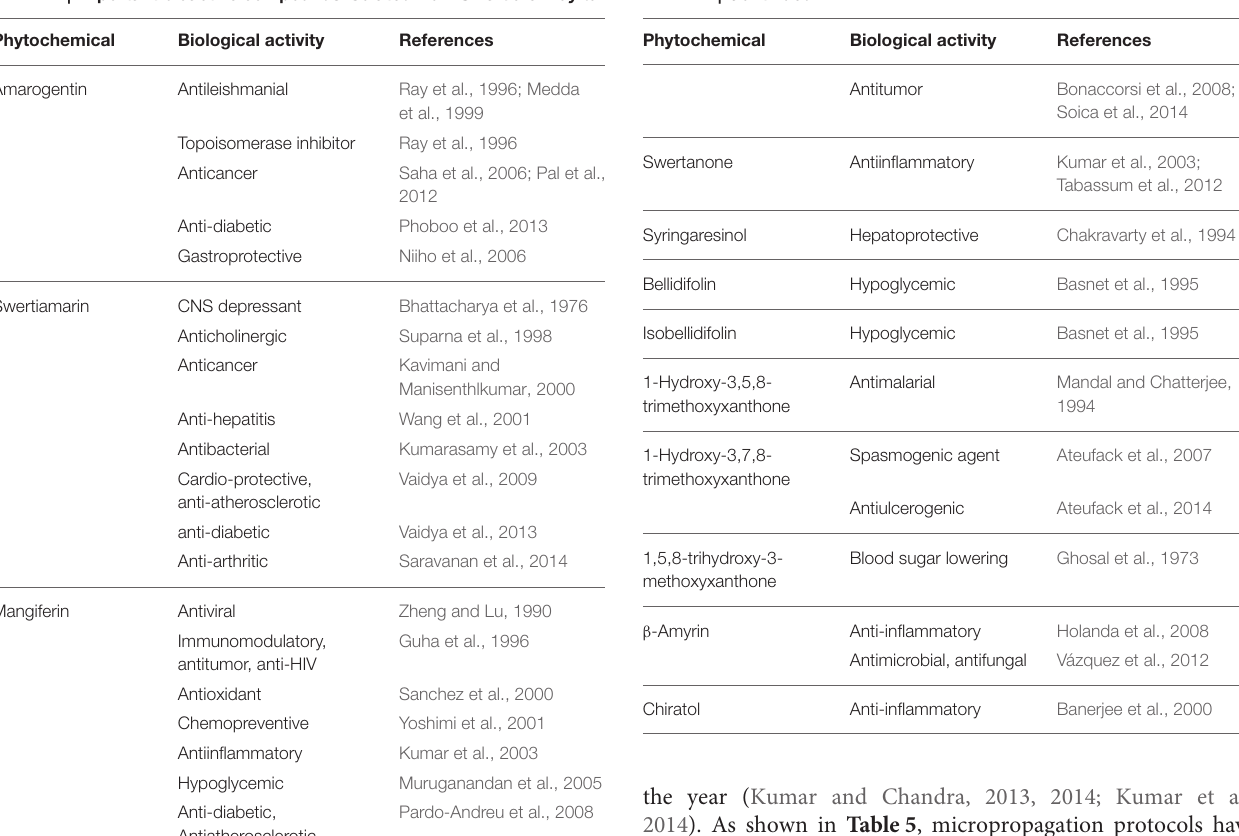
TABLE 4 | Important bioactive compounds isolated from Swertia chirayita